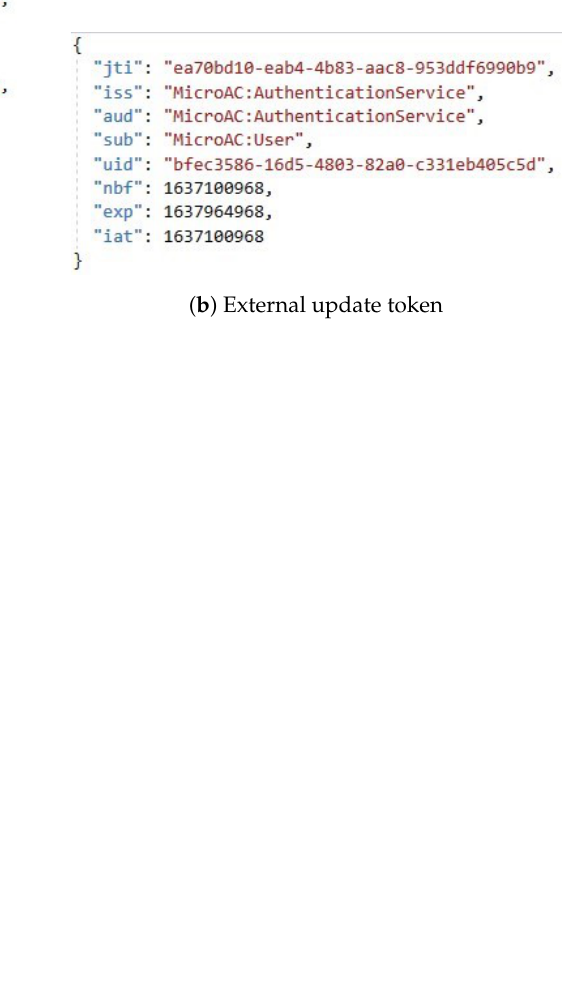
Figure 6. Structure of internal JWT